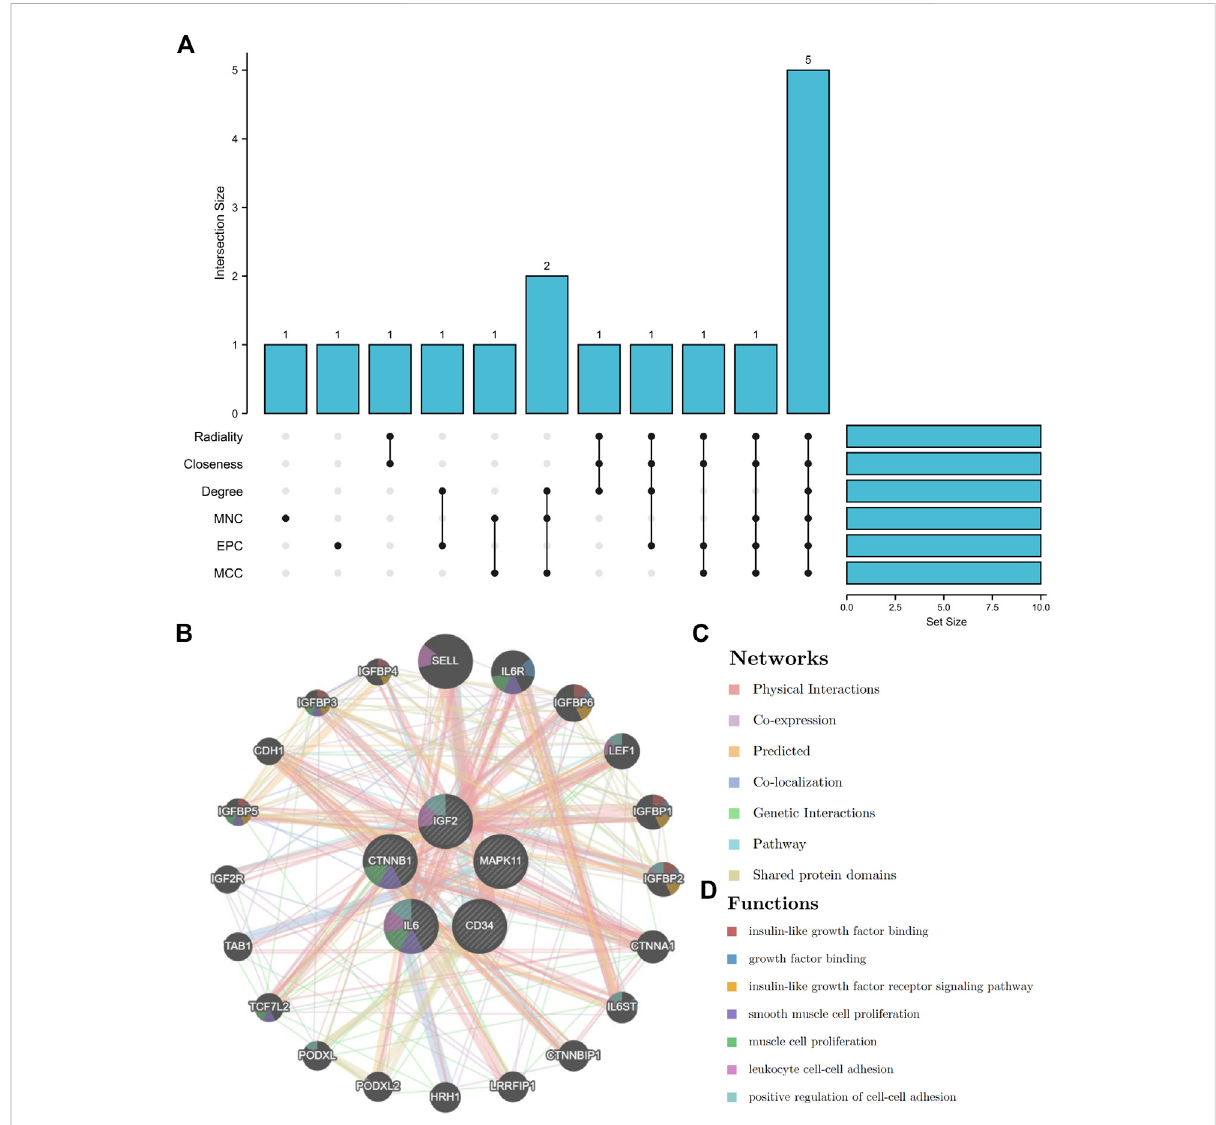
FIGURE 6 The UpSet diagram of hub genes and their co-expression network. (A) , six algorithms of cytoHubba selected 5 overlapped hub genes. (B) , Hub genes and their co-expression